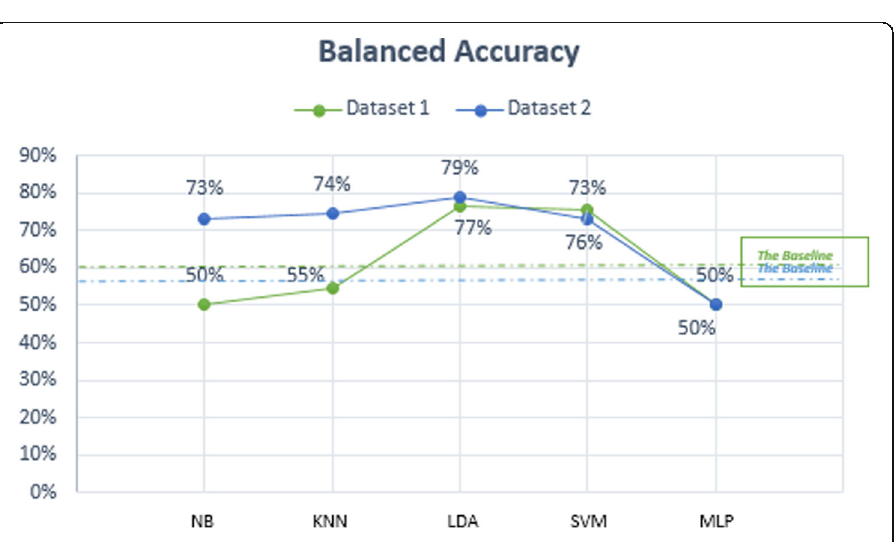
Fig. 13 Class A Balanced Accuracy Rates for Dataset 1 and